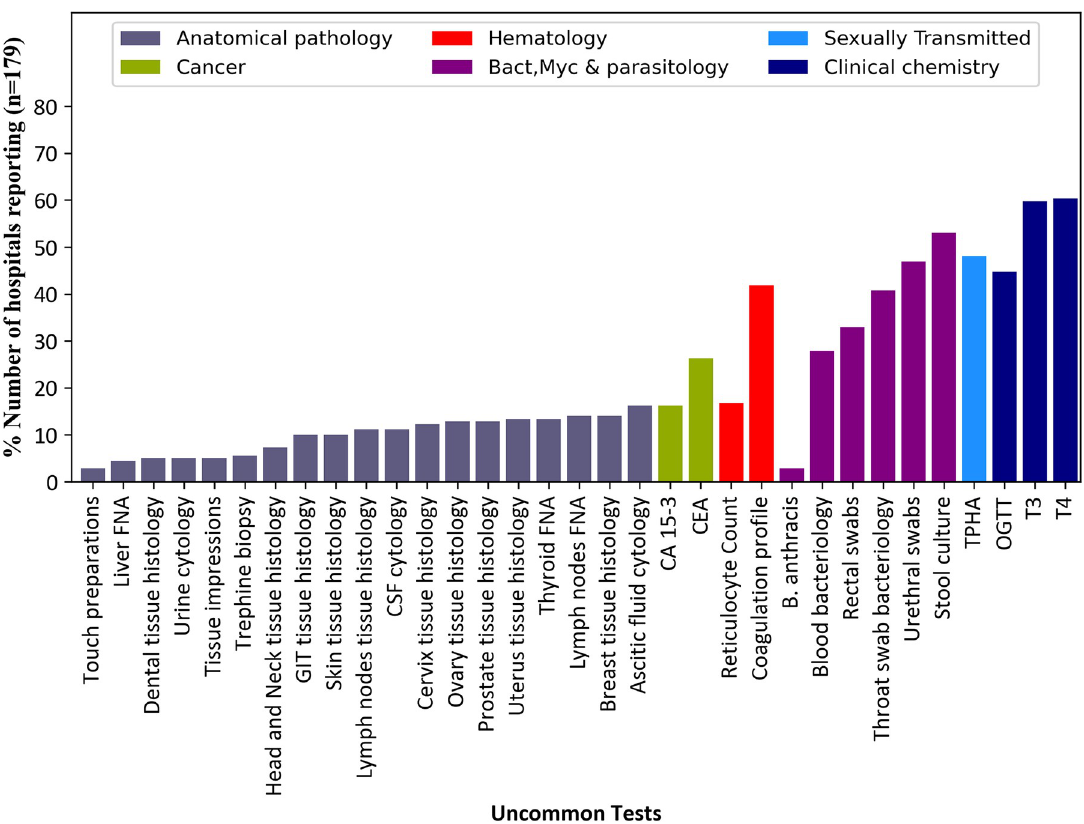
Fig 3. The reporting frequency of the 33 uncommon tests among 179 hospitals submitting data in DHIS2 for the years 2018 and 2019. All uncommon tests reported for at least one month were